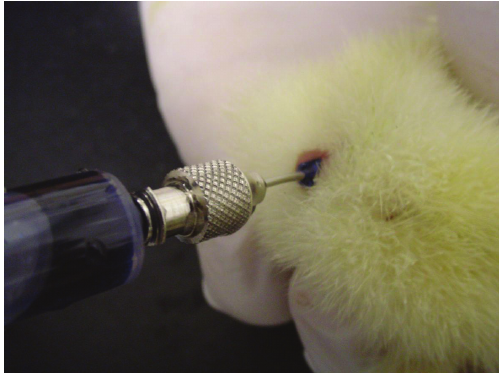
Figure 1: Note leakage of enema in a bird submitted to 0.4 mL methylene blue dye.